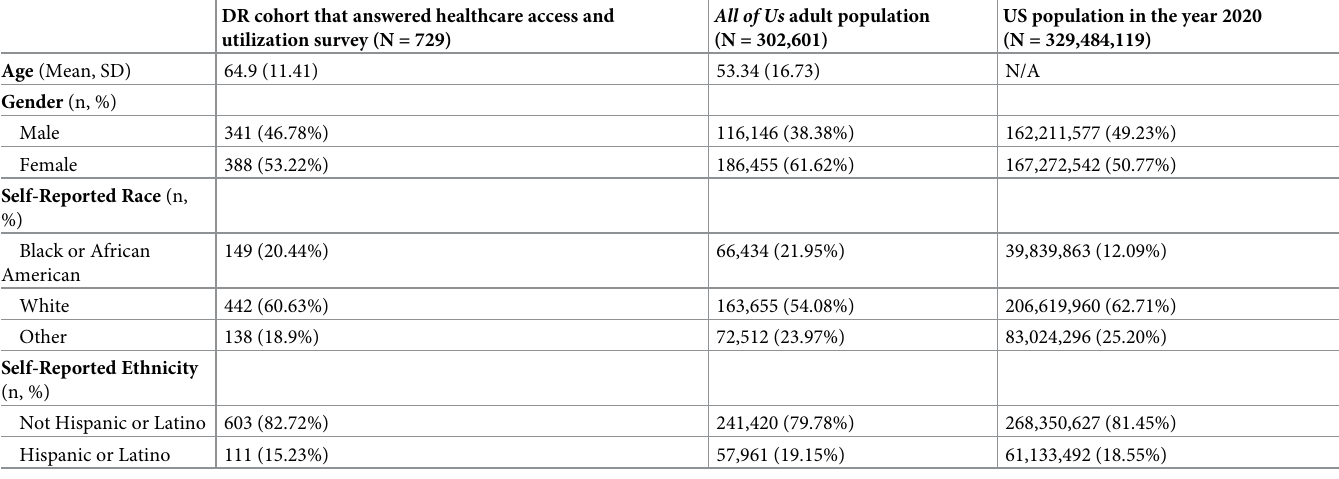
Table 1. Demographic data of DR participants with healthcare access and utilization survey data. Demographics of the general All of Us adult population and the gen- eral United States (US) population based on the 2020 census are included for reference regarding representativeness of the cohort. DR cohort that answered healthcare access and All of Us adult population utilization survey (N = 729) (N =